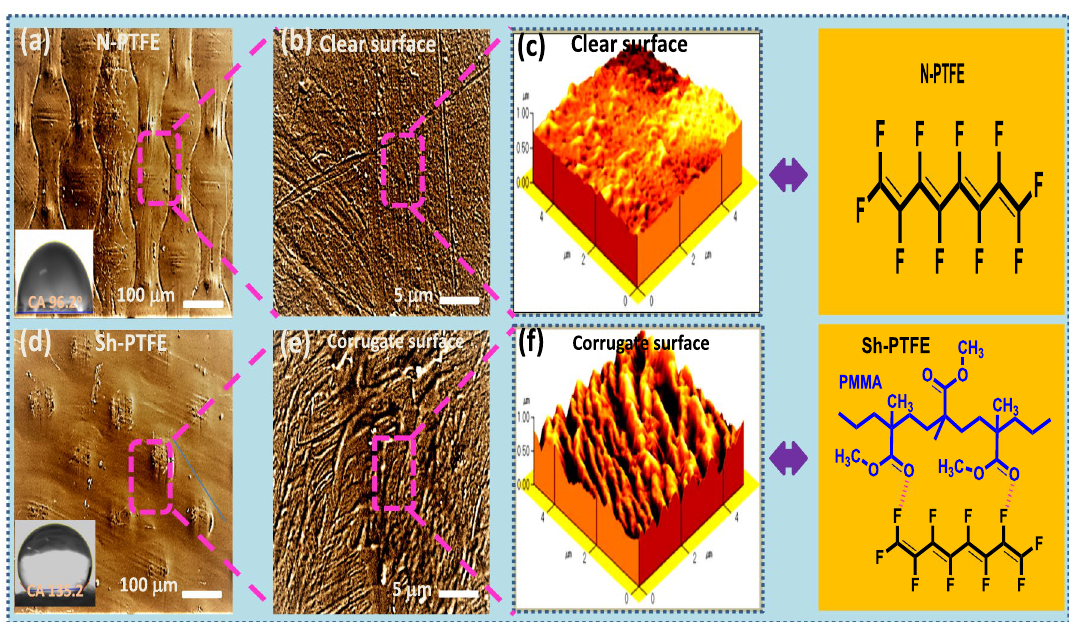
Figure 3. The SEM images showed ( a , b ) clean surface of N-PTFE(inset: CA of 96.2°), and ( d , e ) corrugated surface of Sh-PTFE, (inset: CA of 135.2°). The AFM images revealed ( c ) clear surface morphology on N-PTFE film (the height of the layer ~ 45 nm) ( f ) and corrugate morphology on Sh-PTFE film (the height of the layer ~ 113